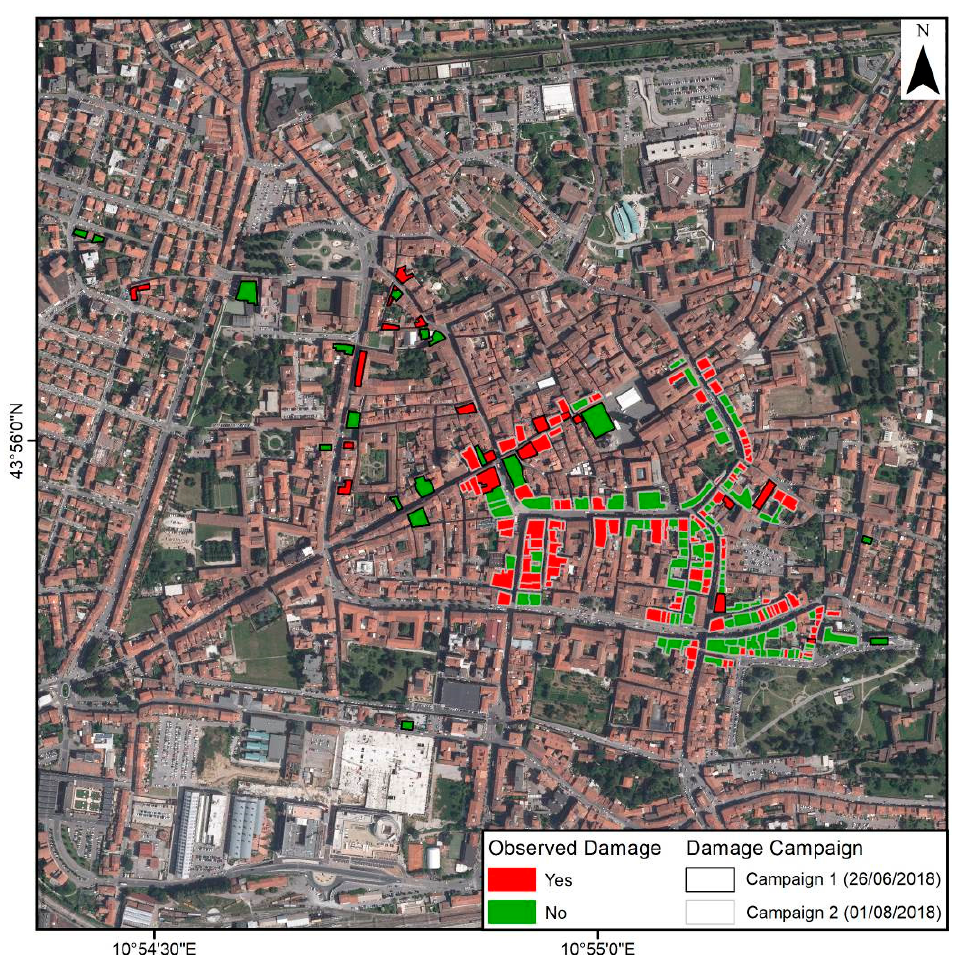
Figure 6. Results of the in-situ damage detection field campaigns.